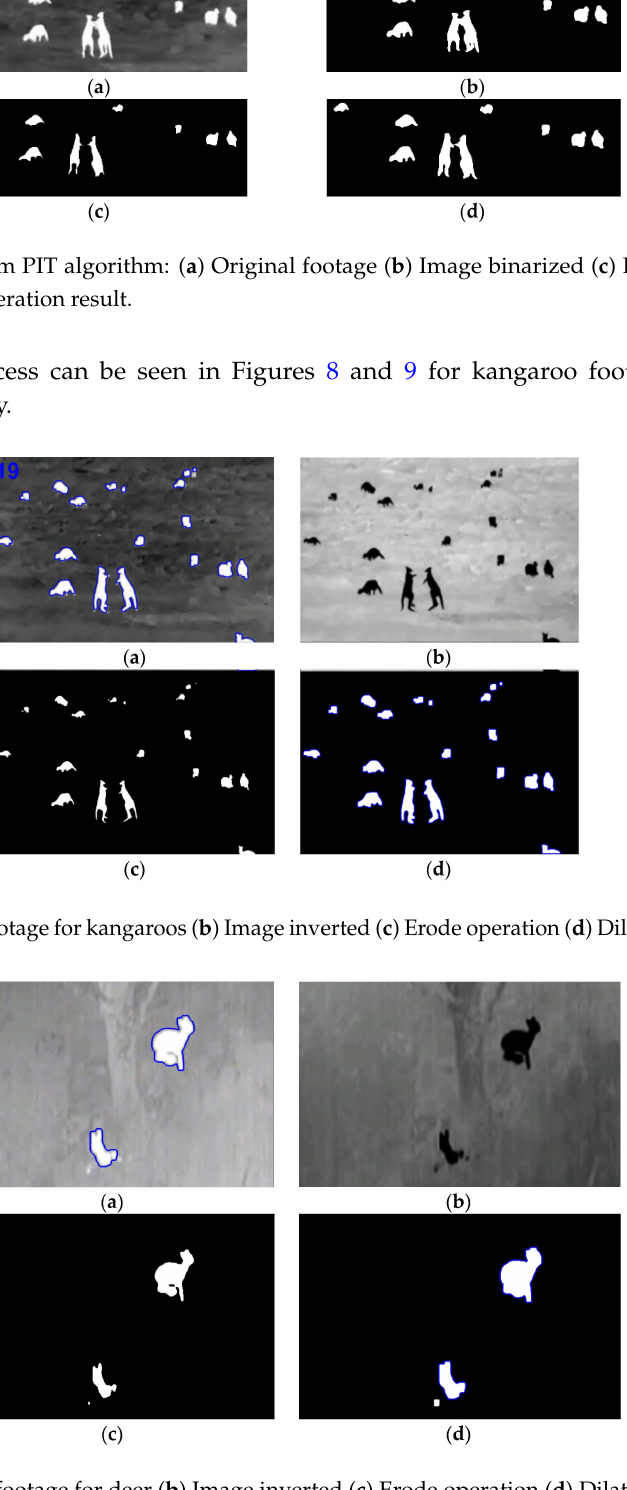
Figure 9. ( a ) Result footage for deer ( b ) Image inverted ( c ) Erode operation ( d ) Dilation and